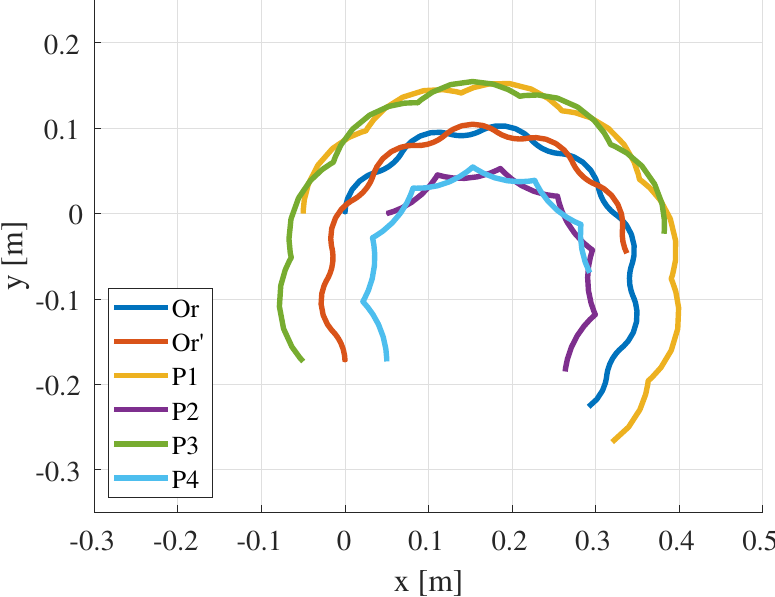
Figure 8. The trajectories of each joint in the simulation for clockwise turning locomotion. The simulation results show that the robot turns to the right by setting β = − π /6.